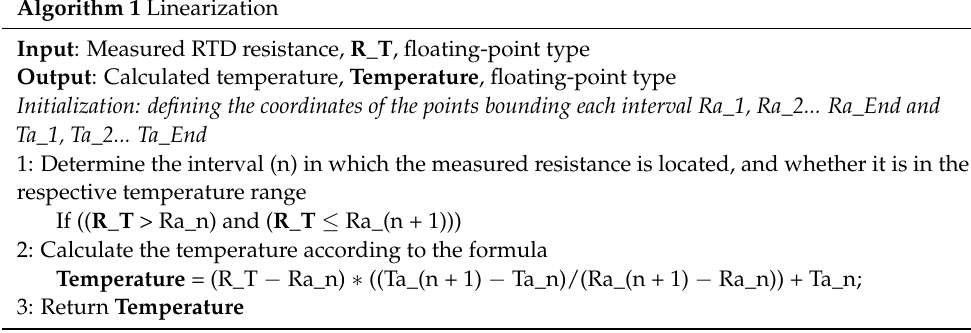
Algorithm 1 Linearization